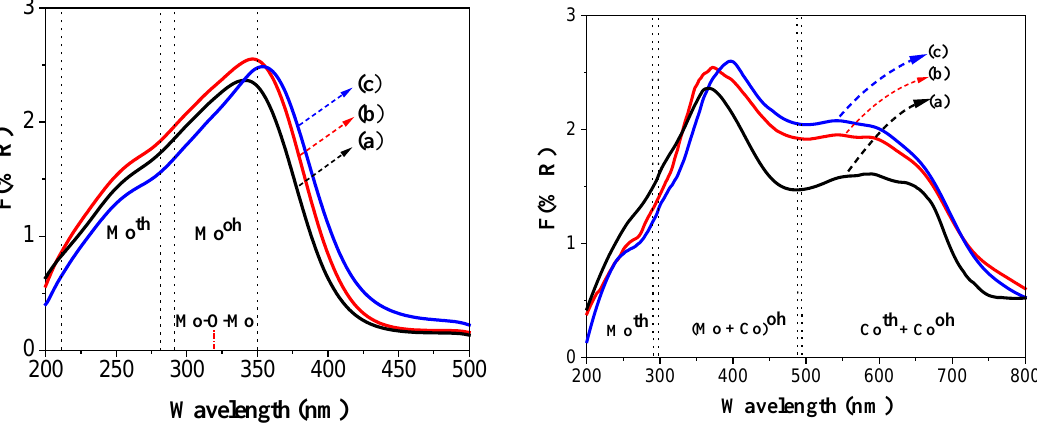
Figure 2. Diffuse reflectance UV-vis spectra of the Mo/AT2 ( left ) and CoMo/AT2 ( right ) catalysts accounting for different loadings of Mo: (a) 10, (b) 12 and (c) 15 wt.%. TPR results of the Mo/AT2 and CoMo/AT2 catalysts with different Mo loadings are shown in Figure 3. In all samples, it is possible to identify three prominent reduction peaks. The reduction peak of Mo/AT2 catalysts near 400 °C indicates the reduction of Mo 6+ → Mo 4+ in octahedral coordination. The second peak, around 650 °C, is attributed to the reduction processes Mo 6+ → Mo 4+ and Mo 4+ → Mo 0 from the mixture of Mo species in octahedral and tetrahedral coordination [53]. Finally, at high temperatures (>600 °C), the reduction of Mo 4+ → Mo 0 in tetrahedral coordination and the TiO 2 (850 °C) from the support takes place [11,22,53]. The deconvolution analysis shows that octahedral Mo species increase their concentration in loadings higher than 10 wt.%. Additionally, the shift to lower temperatures of the middle peak indicates that Mo oh species are easily reducible, i.e., Mo-based materials with a loading of 12 and 15 wt.% will be sulfided easier than with 10 wt.%, due to a decrease in the metal support interaction.